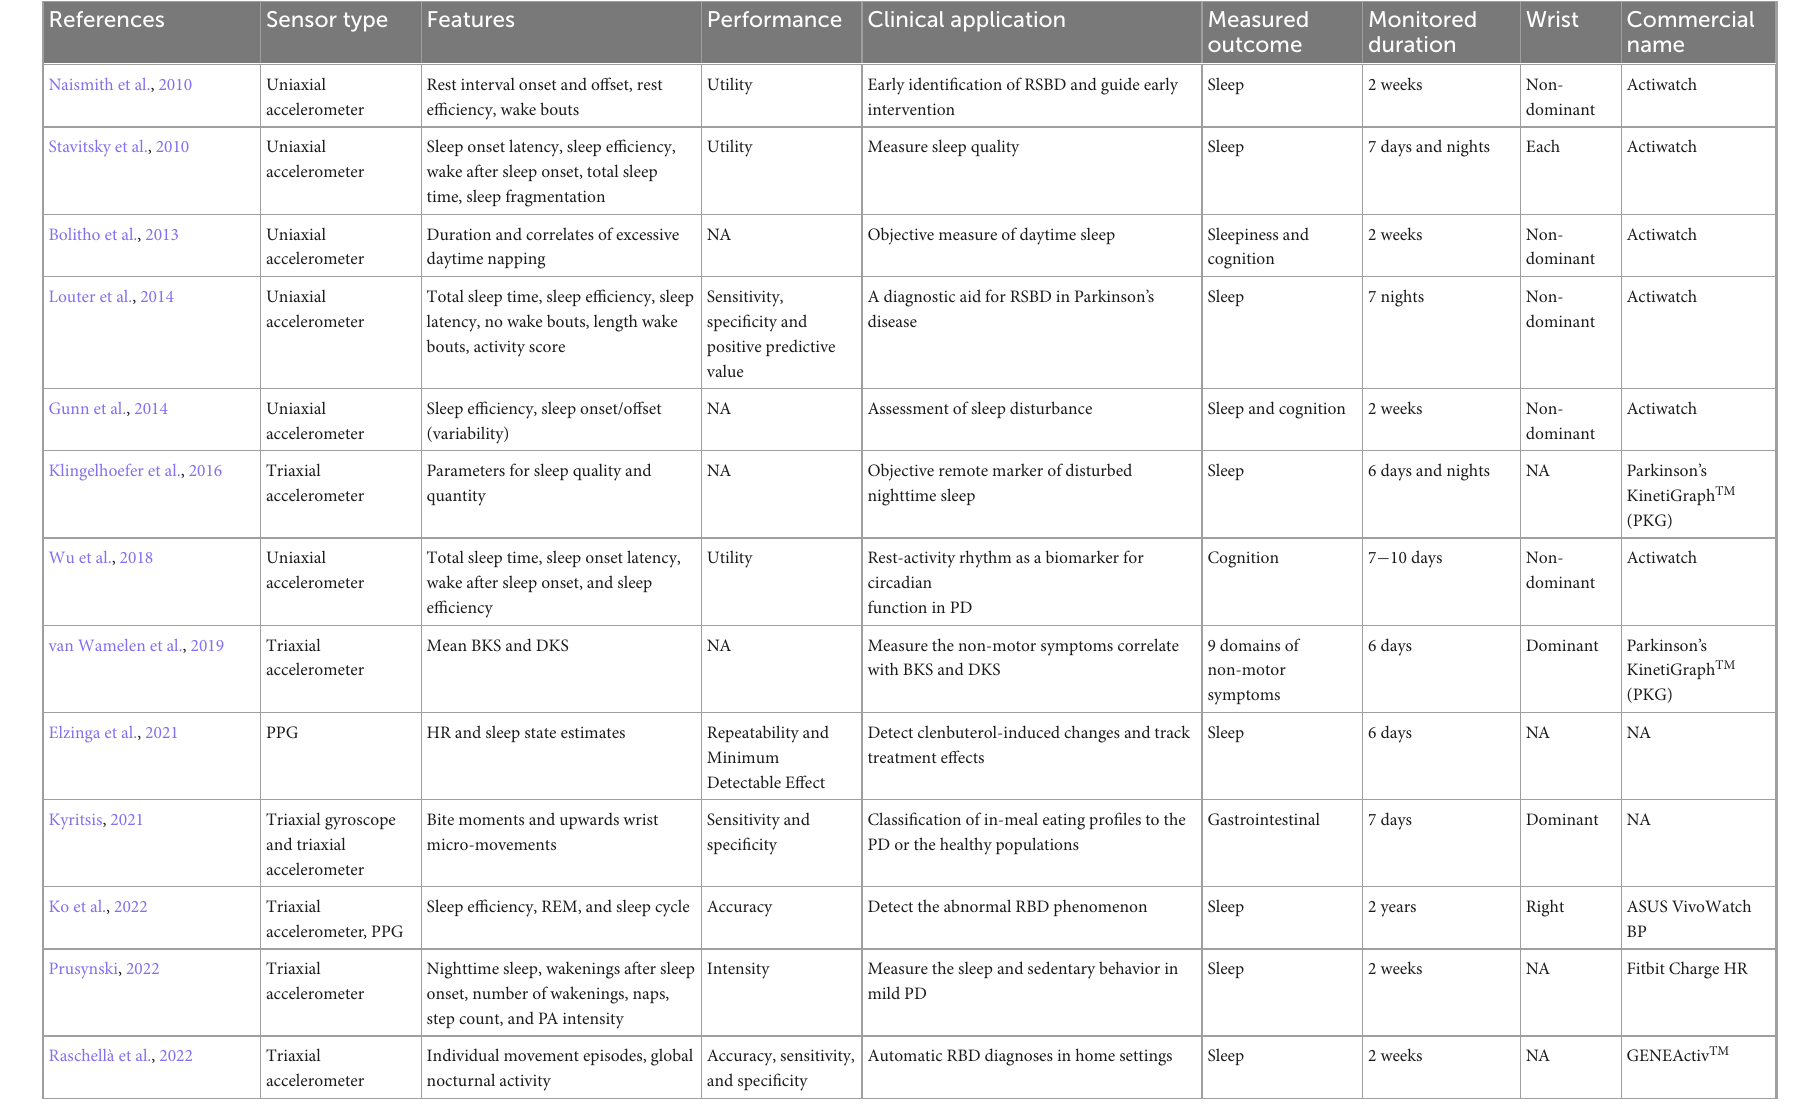
TABLE 3 Articles about wrist-worn commercial devices for telemonitoring non-motor signs in PD and related